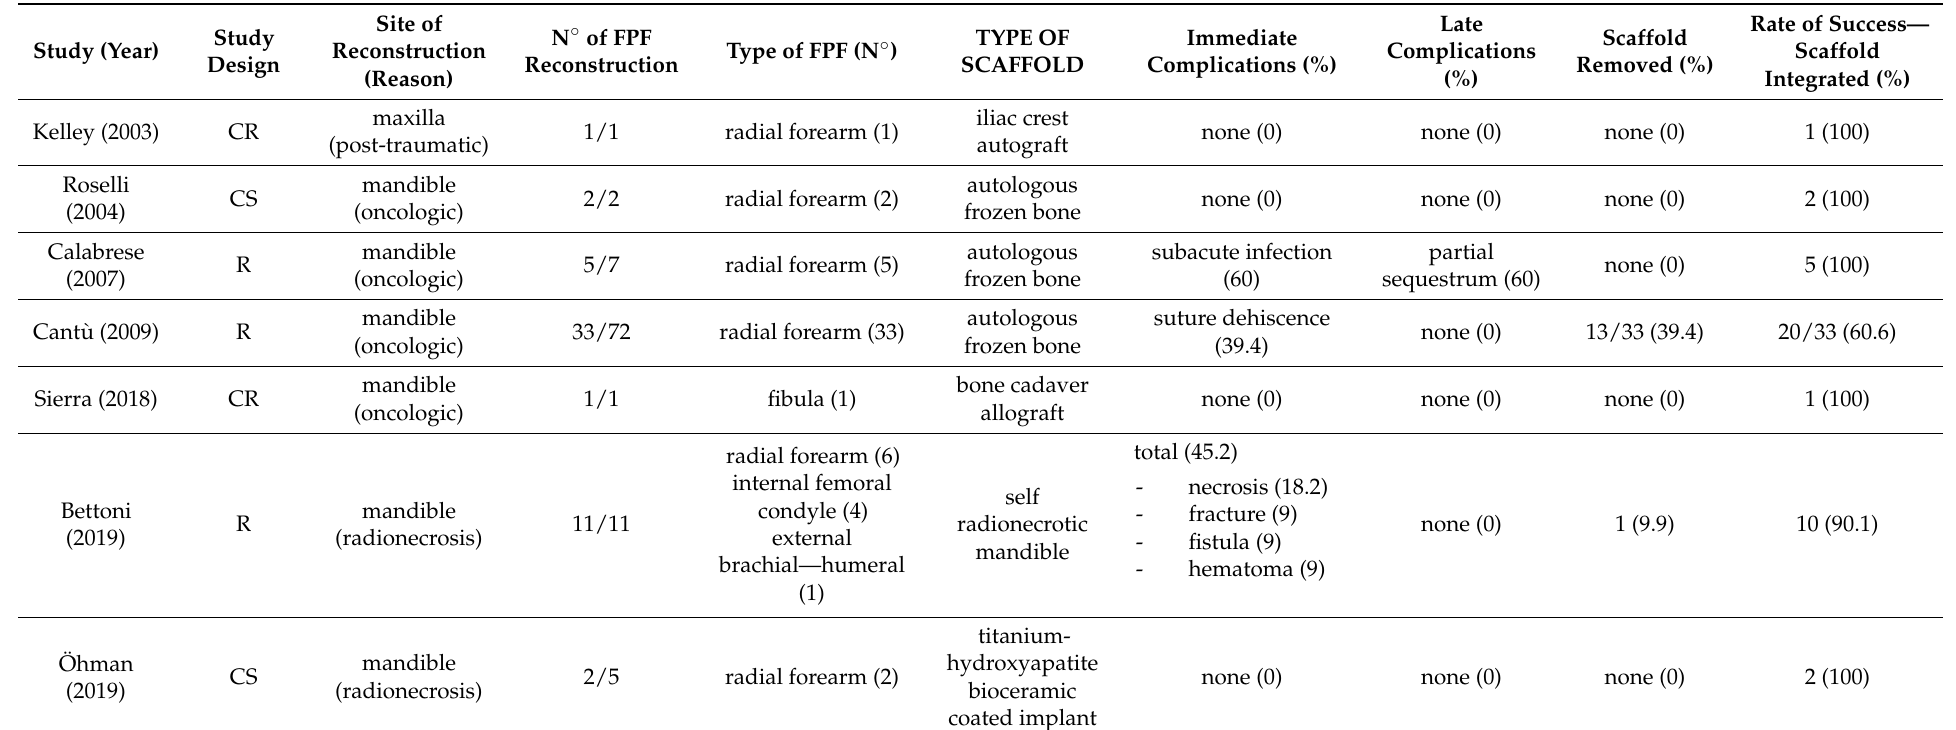
Table 1. Characteristics of included